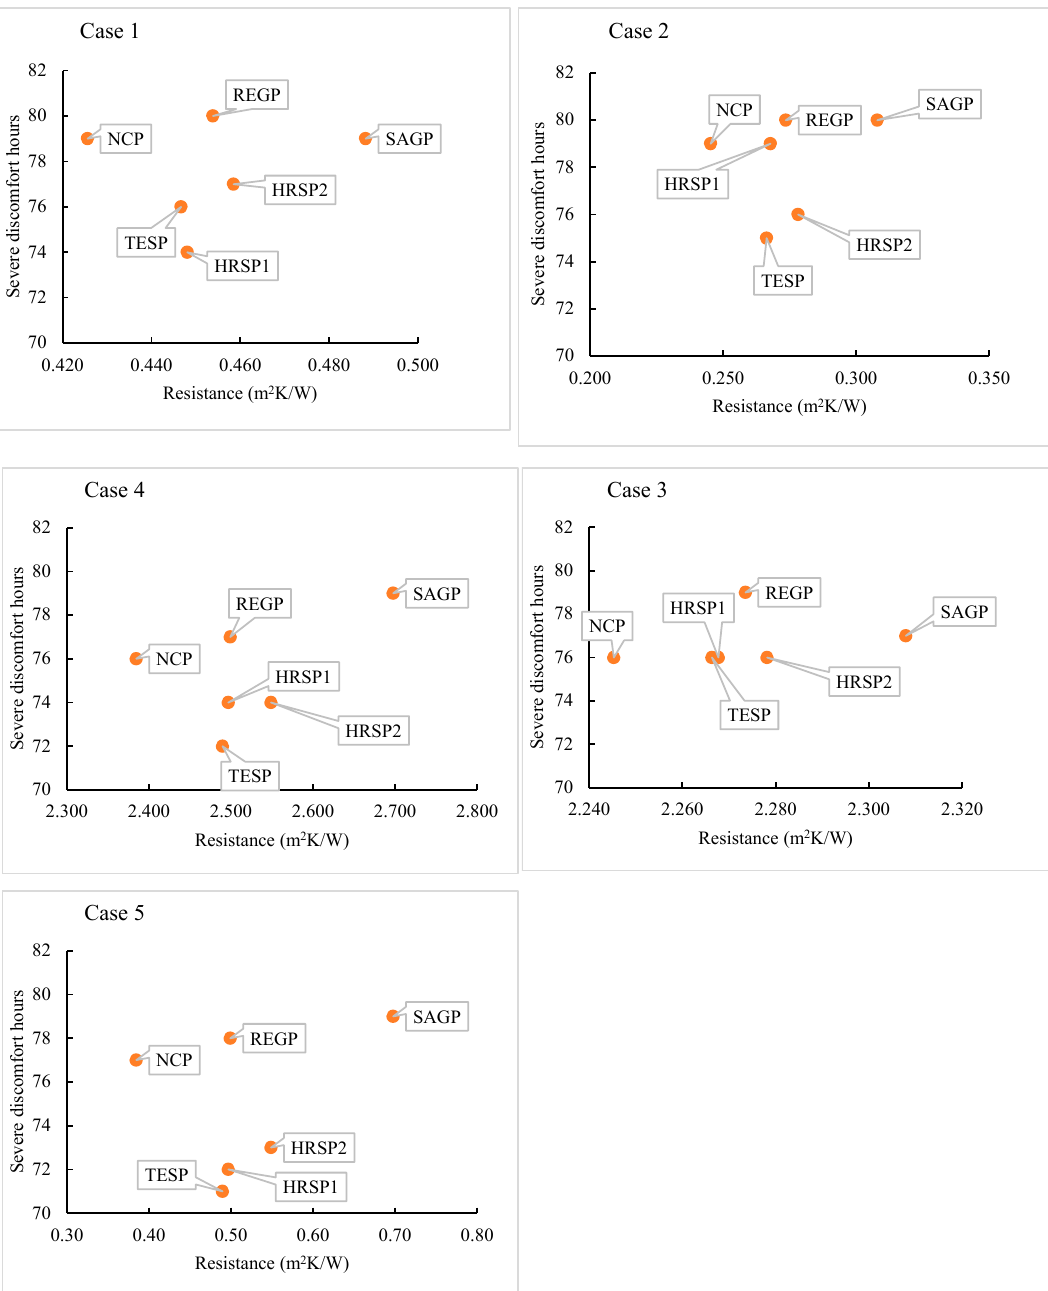
Figure 7. The effect of envelope thermal storage on the number of severe discomfort hours in the living zone.